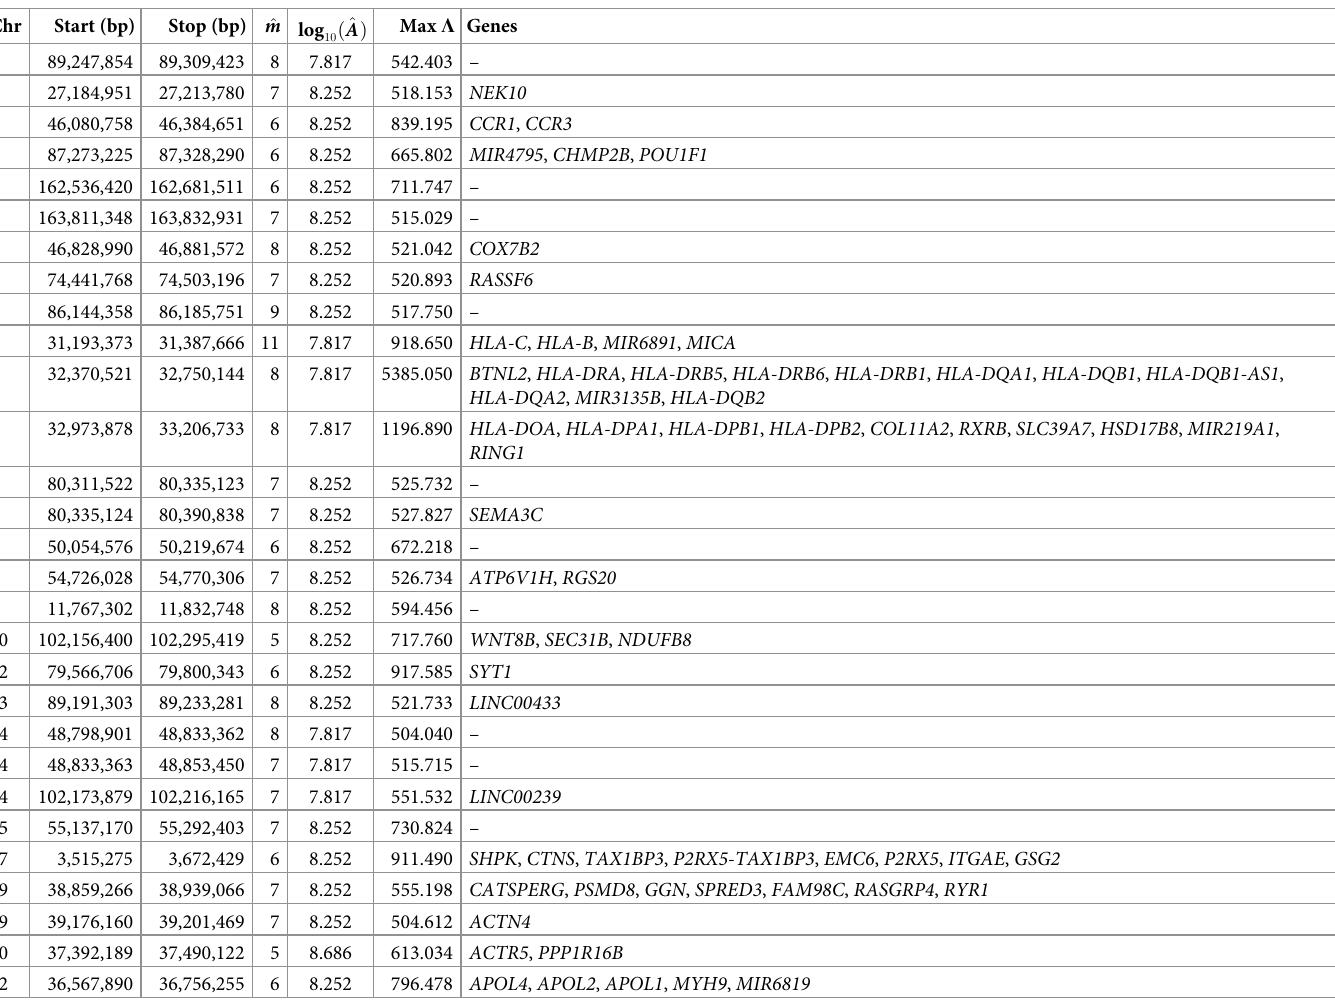
Table 2. Regions of extreme Λ values in the YRI population and the genes contained therein. ^ m is the inferred number of sweeping haplotypes, and log mated sweep